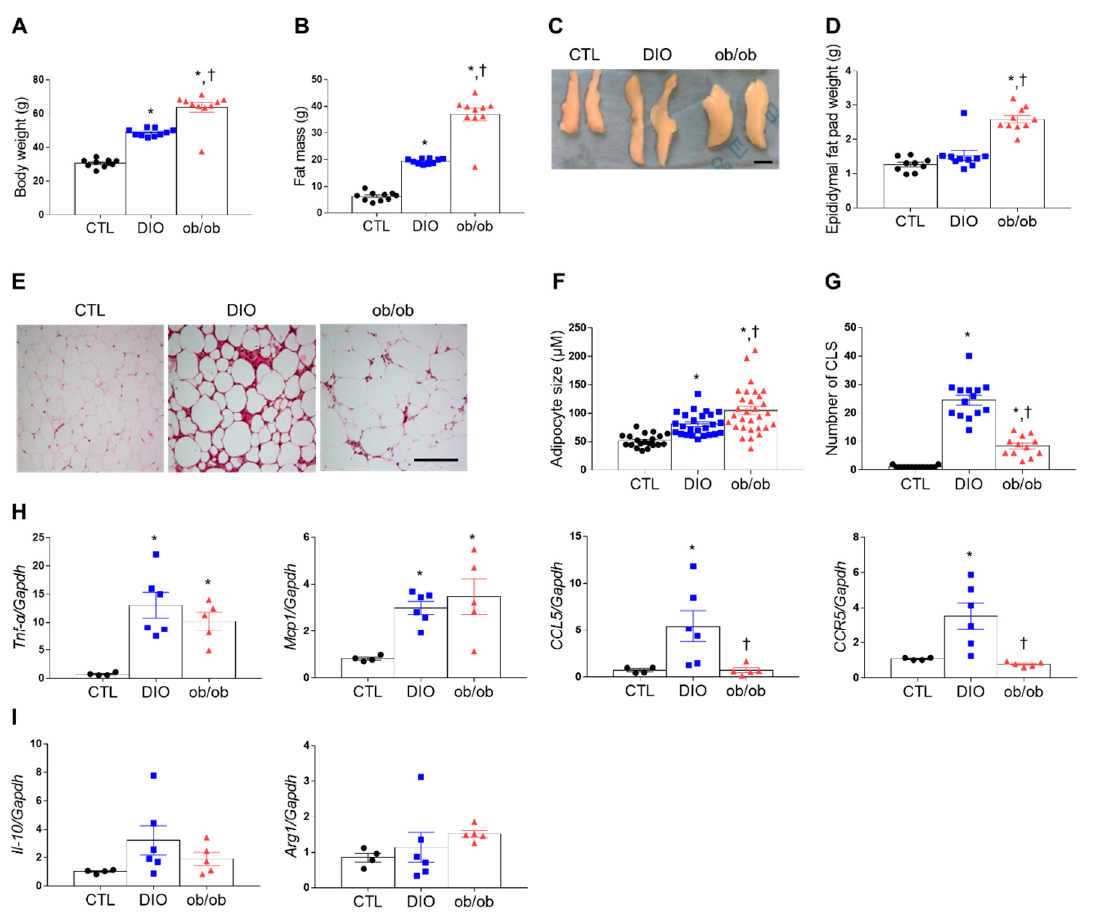
Figure 1. E ff ects of high-fat diet and leptin deficiency on weight gain, fat weight, and adiposity. ( A ) Body weight of mice after 20 weeks of feeding ( n = 10 per group). ( B ) Fat mass weight measured by Echo Magnetic Resonance Imaging (EchoMRI). ( C , D ) Representative photographs ( C ) and weight ( D ) of epididymal adipose tissue. Scale bar = 1 cm. ( E ) Representative images (200 × ) of hematoxylin and eosin (H&E) staining in adipose tissue sections. Scale bar = 100 µ m. ( F ) Adipocyte size ( n = 3). ( G ) Number of crown-like structures (CLSs) measured by H&E-stained epididymal fat ( n = 3). ( H , I ) Quantitative RT-PCR analysis of tumor necrosis factor- α (Tnf- α ), monocyte chemoattractant protein 1 (Mcp1), CC chemokine ligand 5 (CCL5), C-C motif receptor 5 (CCR5), interleukin-10 (Il-10), and arginase 1 (Arg1) mRNA. Data are presented as the means ± standard of error of the mean (SEM). * p < 0.05 versus control (CTL) mice; † p < 0.05 versus diet-induced obesity (DIO) mice. CTL (black circle), DIO (blue square), ob / ob (red triangle).